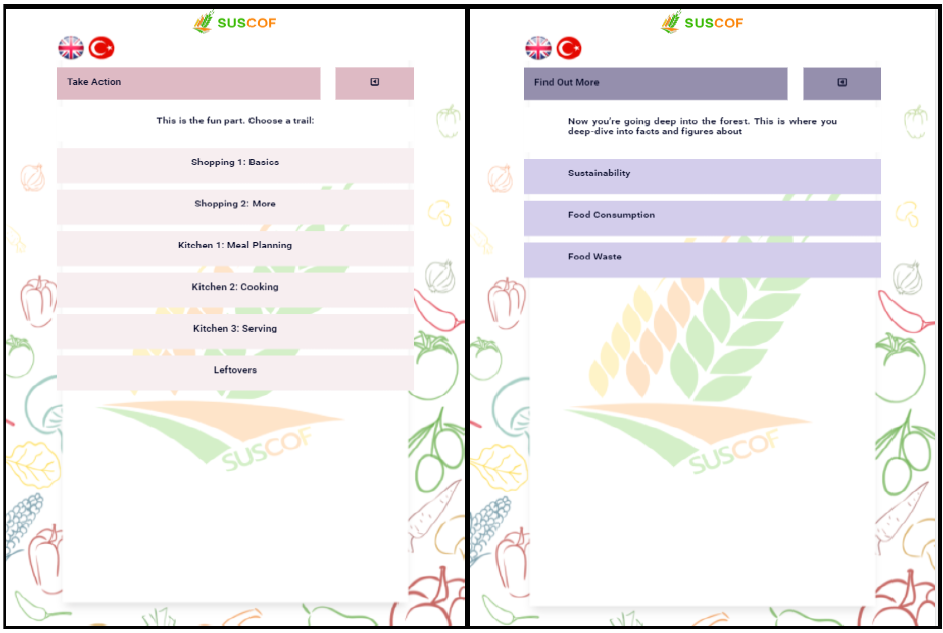
Figure 6. “Take Action” and “Find Out More” Screen.